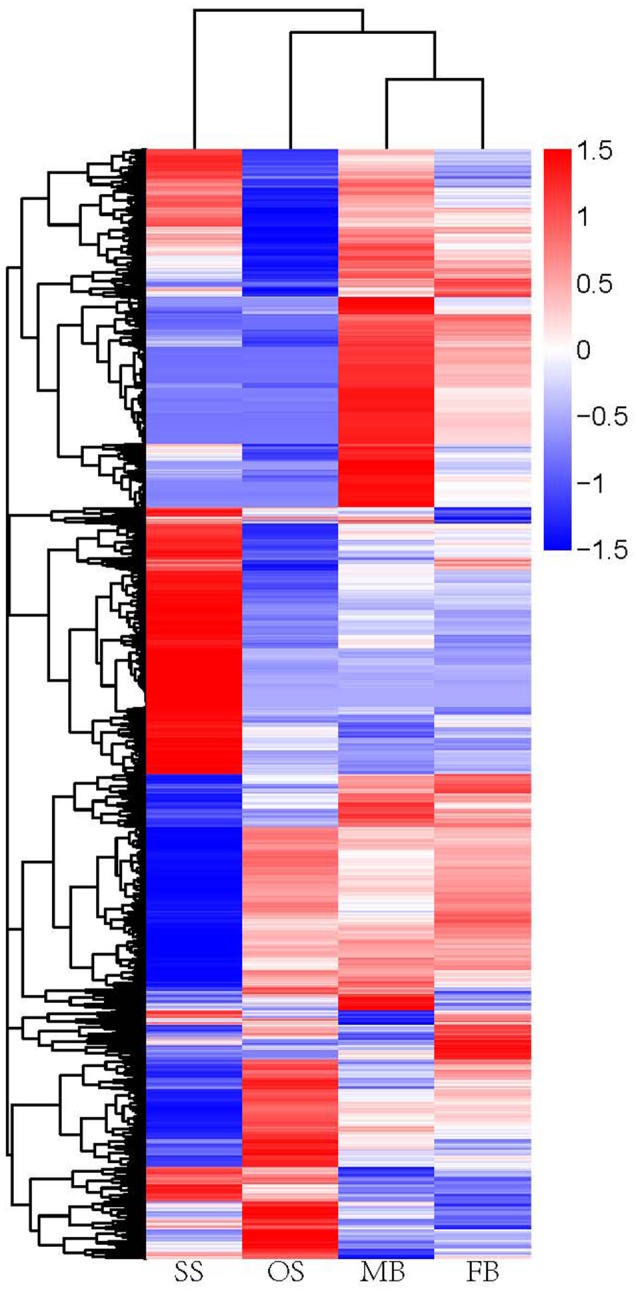
Heatmap of hierarchical clustering of DEGs. Each column represens a sample, each row represents a unigene. The differences in expression level were shown in distinct colors. Positive numbers indicate up-regulation DEGs and negative number indicates down-regulated DEGs. SS, staminate strobilus; OS, ovulate strobilus; MB, male bud; FB, female bud.